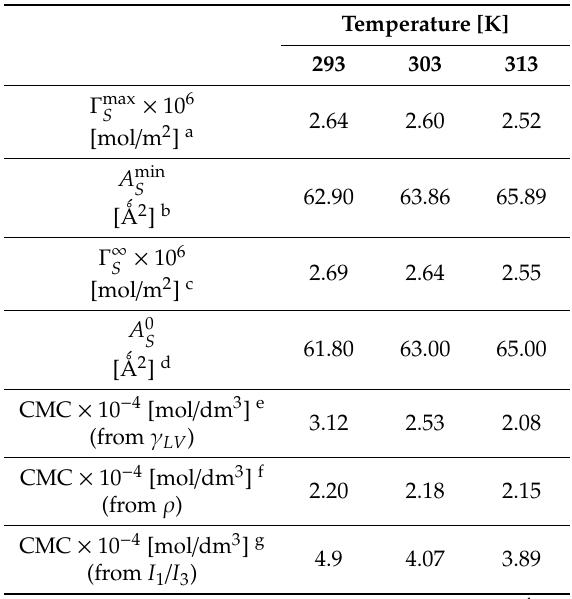
), limiting Gibbs surface excess concentration ( Γ S